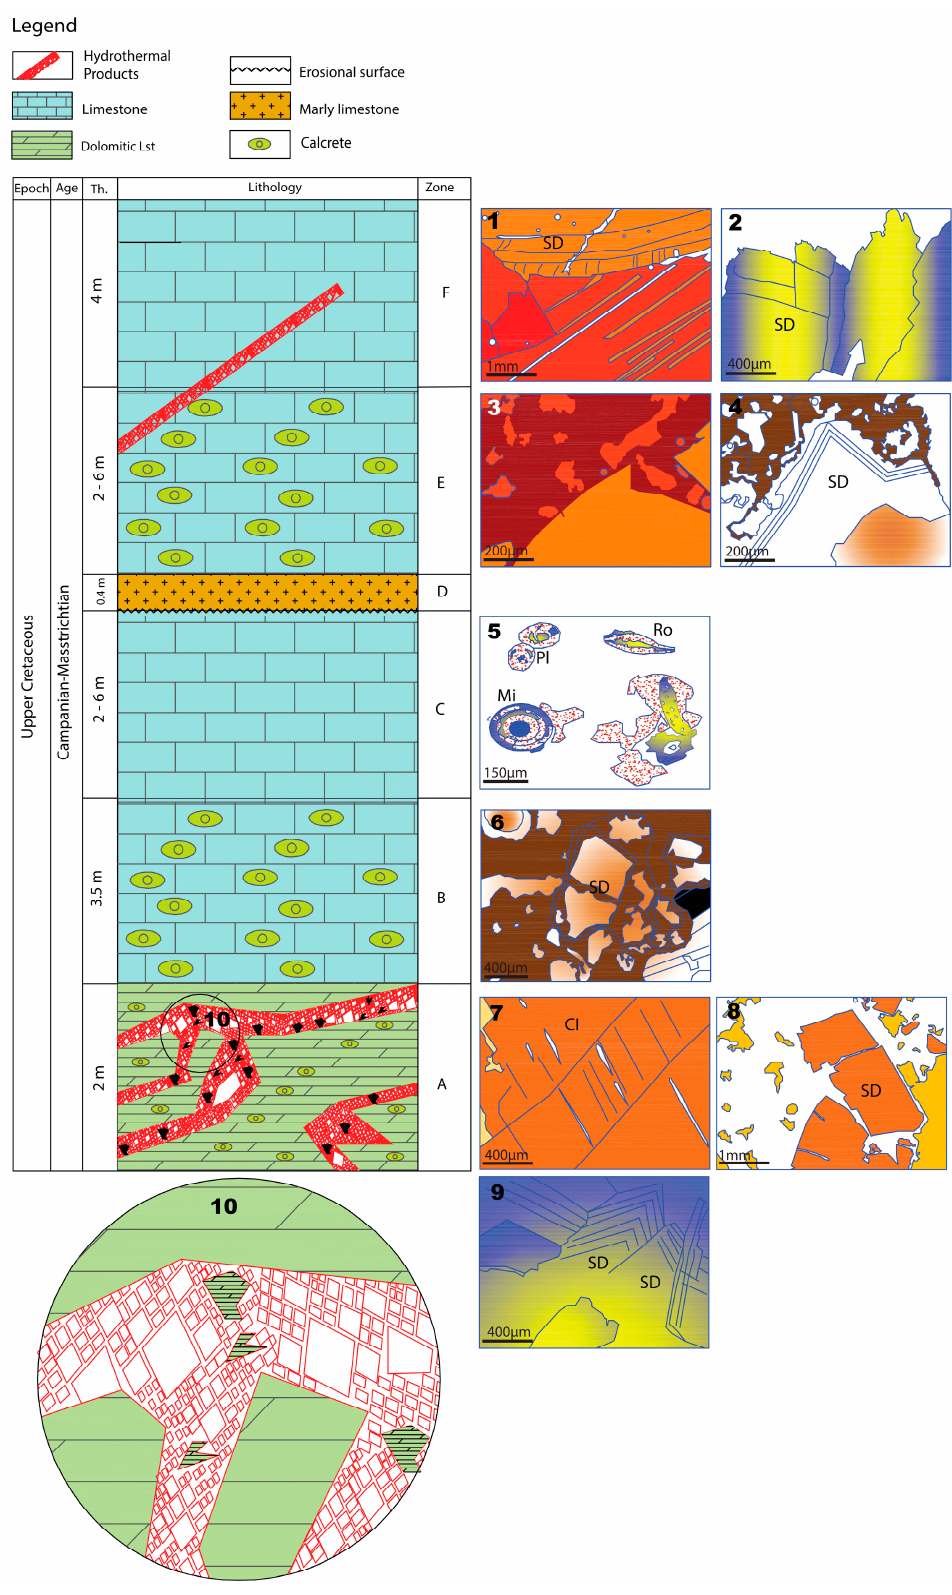
Figure 8. Litho-log of the Bekhme Formation from the Spelek–Sulauk area, and, next to each zone, the digitized microphotographs illustrating the significant alteration of HT and non-HT diagenesis on the carbonate rocks. The log shows the emergence (zones B and E) and submergence (zones C and F)